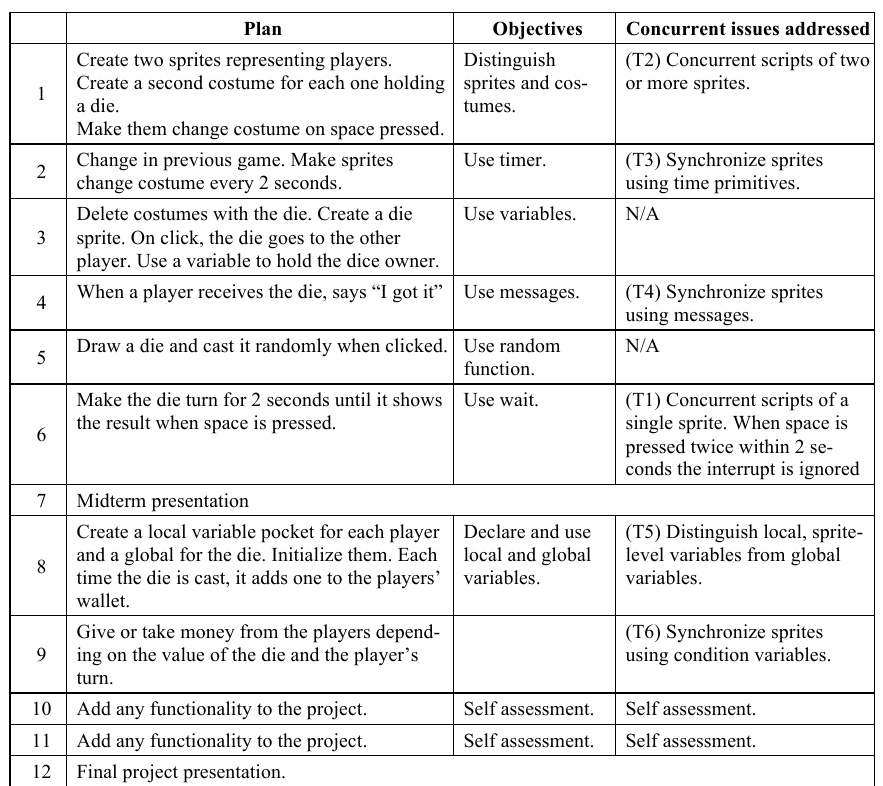
Table 2. Advanced project